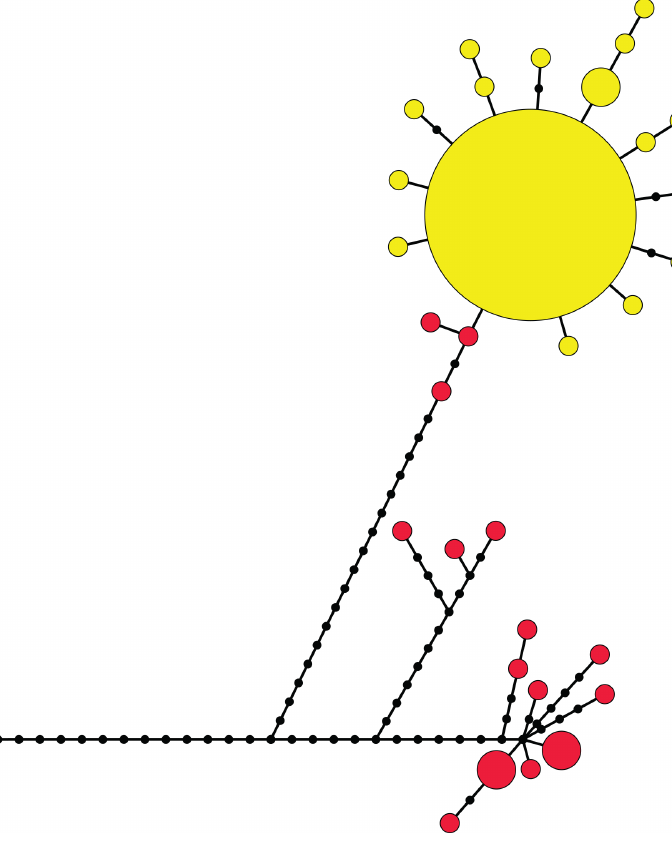
Fig 1. Maximum Parsimony Haplotype Network: including 55 individuals of Galaxias maculatus collected from a migratory population (Valdivia River) and a resident one (Colico Lake). Each mtDNA D-loop haplotype is represented by a colored circle indicating the locality where it was collected (Red = Valdivia River; Yellow = Colico Lake). The size of the circles is proportional to its frequencies in the whole data set. Small black circles indicate mutational steps along the